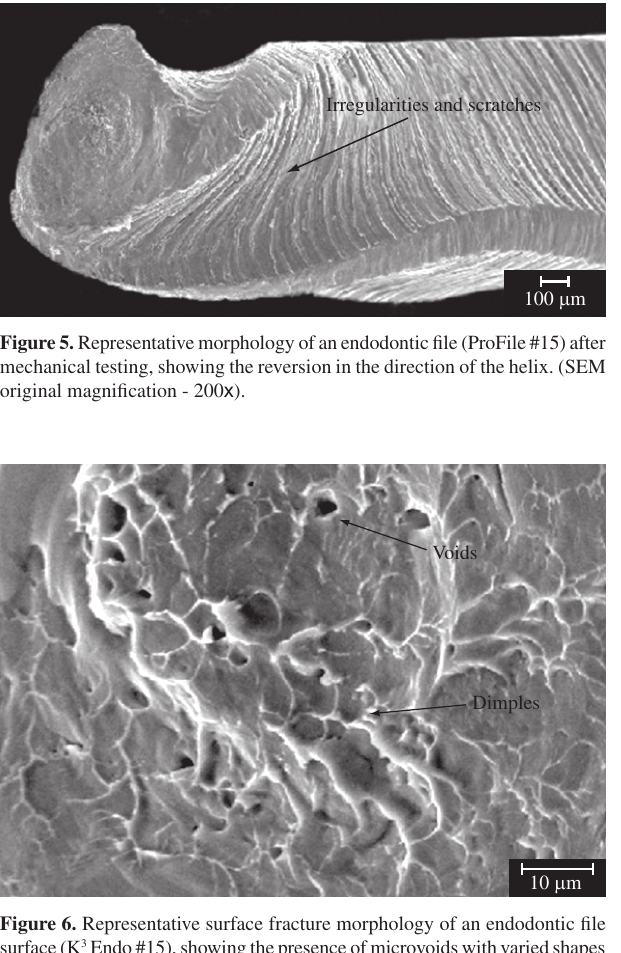
Irregularities and scratches